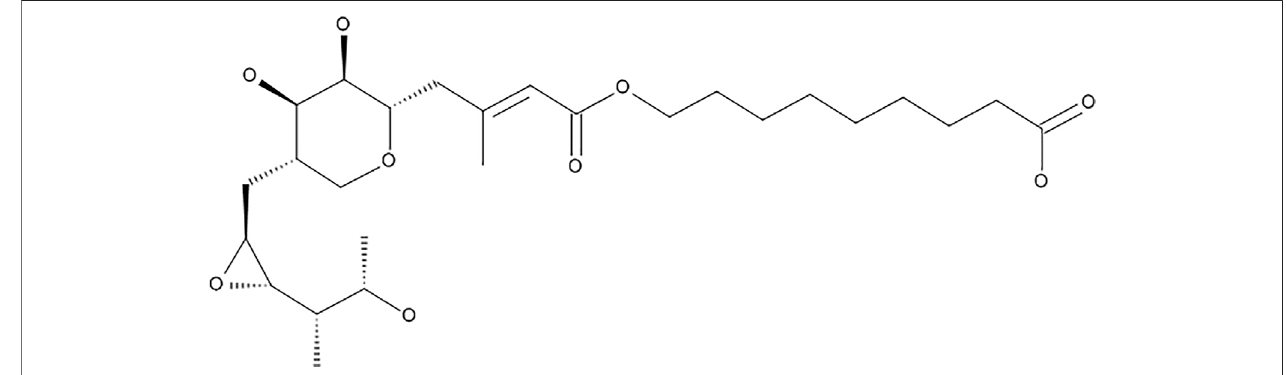
FIGURE 1 | Chemical structure of mupirocin (pseudomonic acid